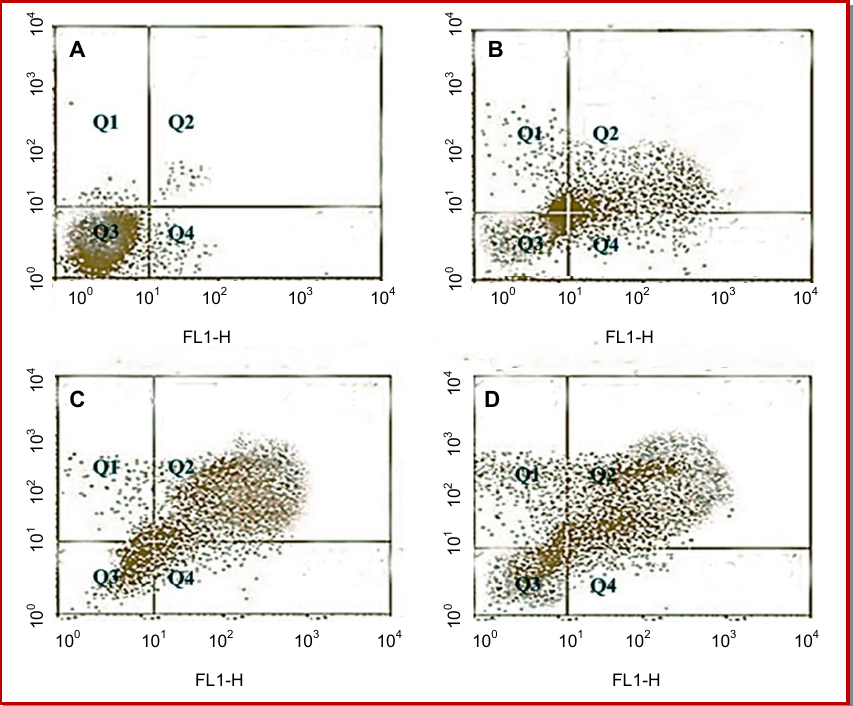
Figure 5: Evaluation of the apoptosis induction by daucosterol in HCT-116 human colon cancer cells using flow cytometry. The cells were treated with 0 (A-0.5% DMSO-PBS), 5 (B), 50 (C) and 100 µM (D) dose of daucosterol and then incubated for 48 hours stained with annexin V-FITC and then analyzed by flow cytometry. Data summary and analysis of the proportion of HCT-116 cells in different periods was according to the results of flow cytometric